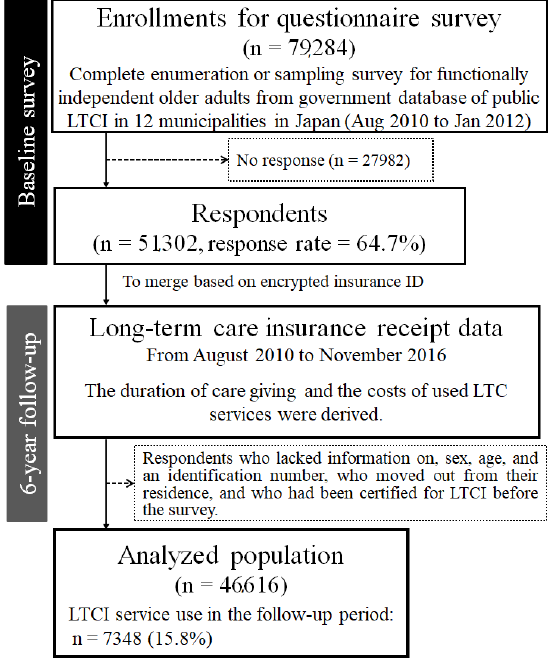
Figure 1. Flow diagram of the analyzed population.